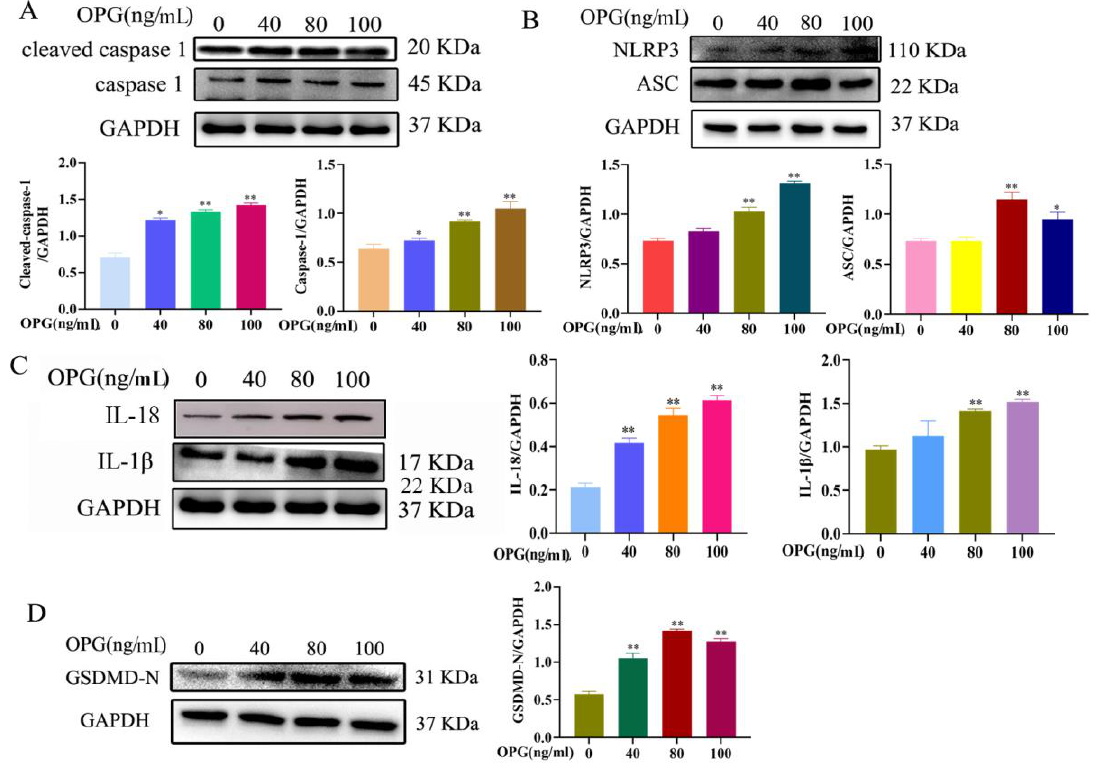
Figure 4. Effects of OPG on expression levels of pyroptosis pathway-related proteins of osteoclasts. ( A ). The expression of cleaved caspase 1 and caspase 1; ( B ). The expression of NLRP3; ( C ). The expression of IL-18 and IL-1 β ; ( D ). The expression of GSDMD-N. ASC, Caspase-1, IL-18, IL-1 β , NLRP3, and GSDMD were quantified by Western blot. (mean ± SD, n = 3, * p < 0.05, ** p < 0.01).